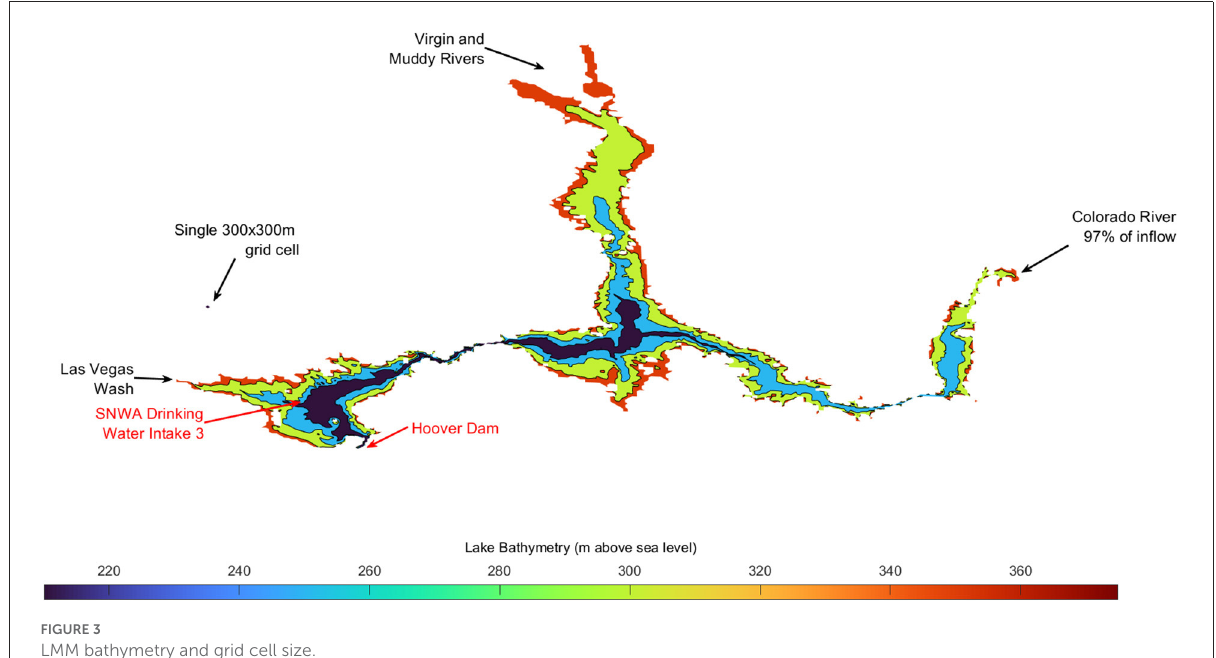
FIGURE3 LMM bathymetry and grid cell size.